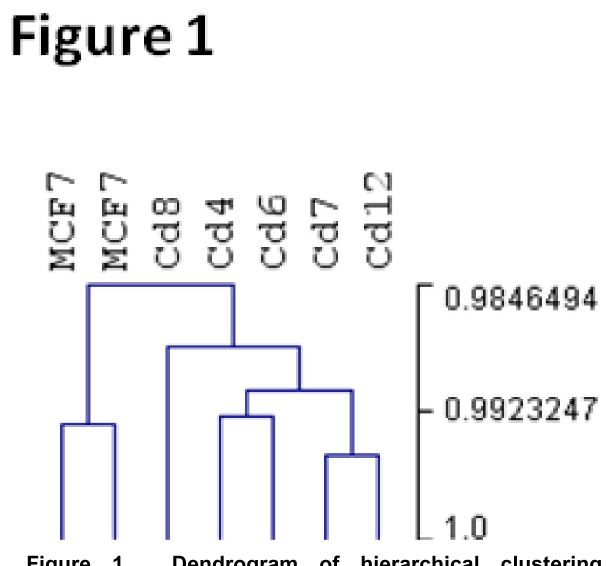
Figure 1. Dendrogram of hierarchical clustering